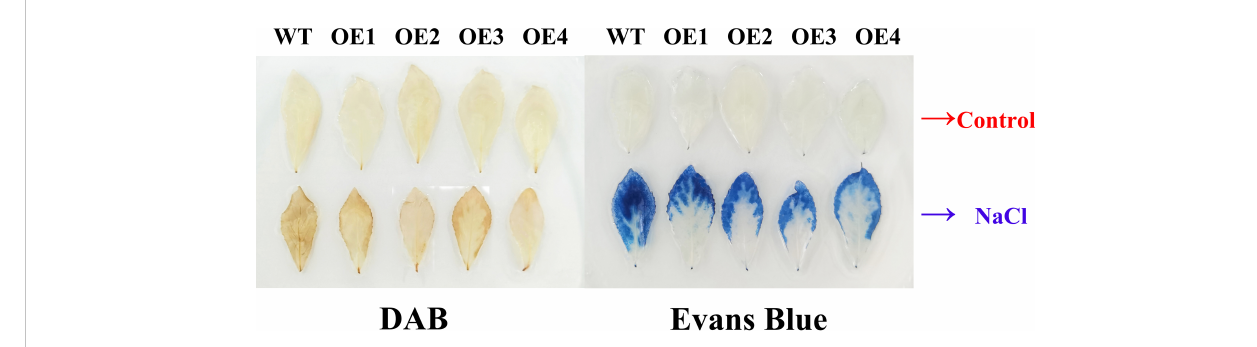
FIGURE 10 Histochemical staining analysis of poplar leaves. The tissue culture seedling leaves of WT and overexpressed PsnHSF21 poplar were treated with 150 mM NaCl and water for 24 h, then stained with DAB (diaminobenzidine) and Evans Blue,